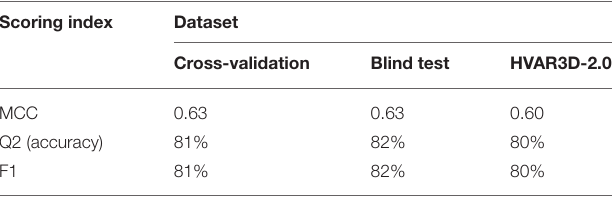
TABLE 3 | Performance of our deep learning-based method for predicting solvent exposure from protein sequence.